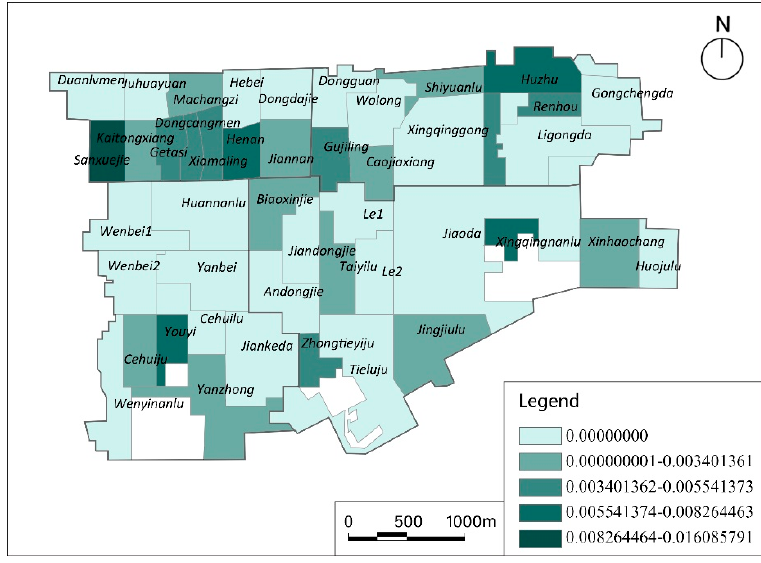
Figure 6. Calculation results of the potential model.